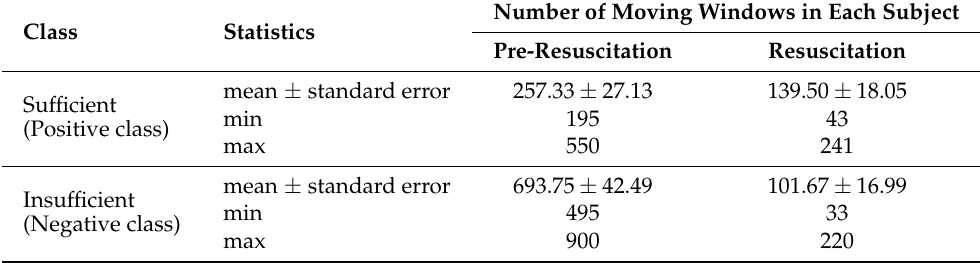
Table A1. The statistics of the number of moving windows in different